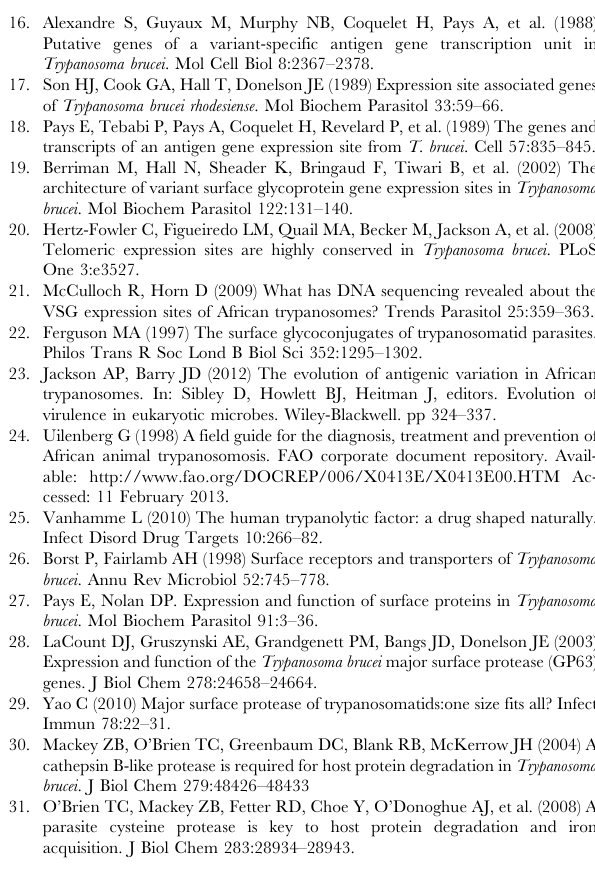
Figure S1 Flowchart describing how the cell-surface phylome was compiled. Figure S2 Distribution of unambiguous, apomorphic characters in ESAG4. The figure shows an amino acid sequence alignment